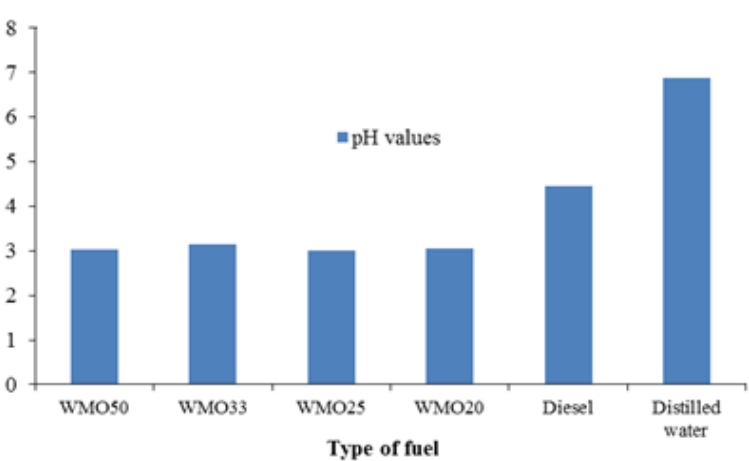
Figure 8. pH variations in the solution during the flue gas purification for different fuel types.